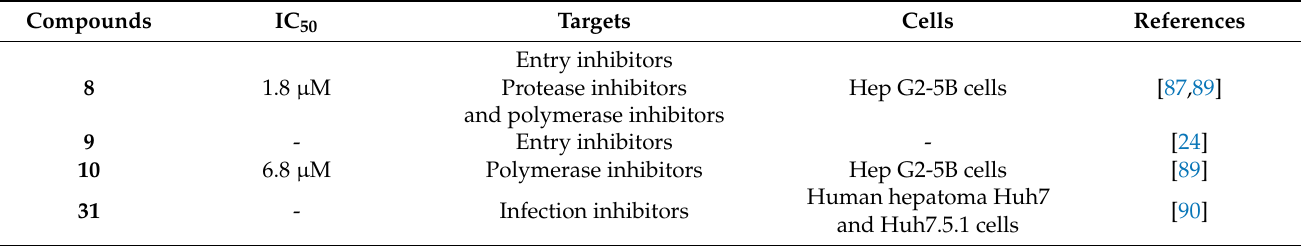
Table 6. Summary of anti-HCV triterpenoids and their targets and activities.